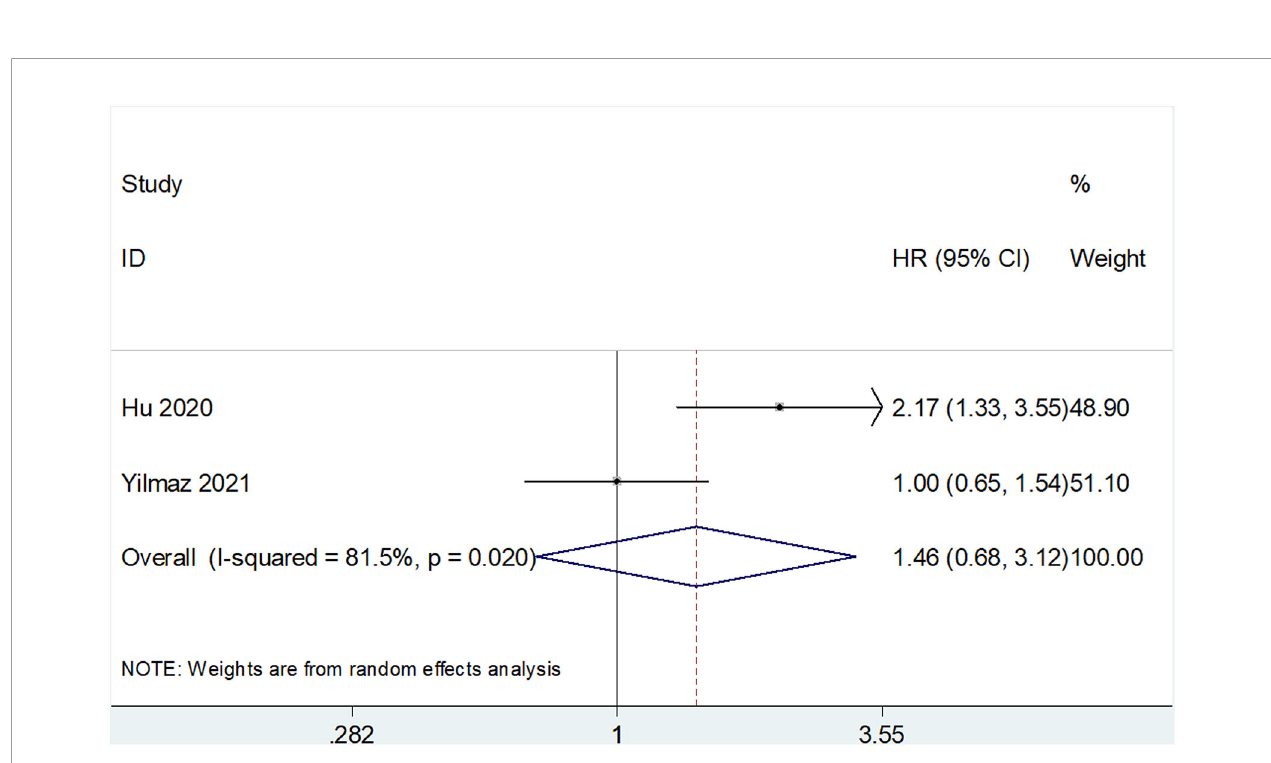
FIGURE 4 | Forest plots showing the association between SII and cancer-speci fi c survival (CSS) in RCC.